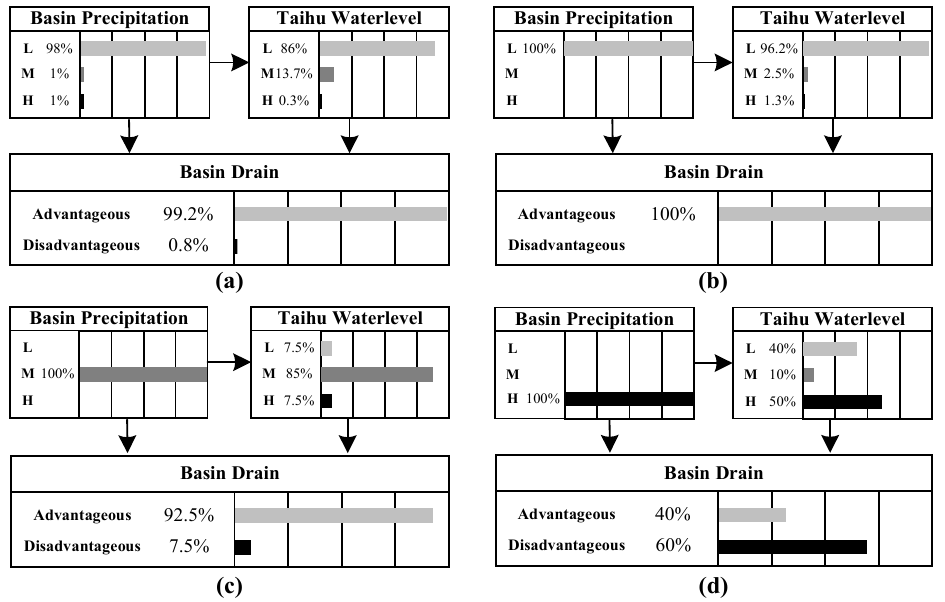
Figure 12. Priori reasoning of the Bayesian network ( a ), and the posterior probability of various precipitation situations ( b ), ( c ), ( d ) in the typhoon period.